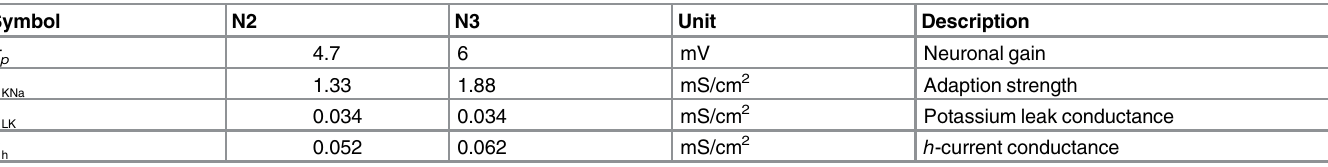
Parameter settings of the full model. This table shows the different parameter settings of the full model used throughout this study. Columns N2 and N3 give the parameters for the respective sleep stages.